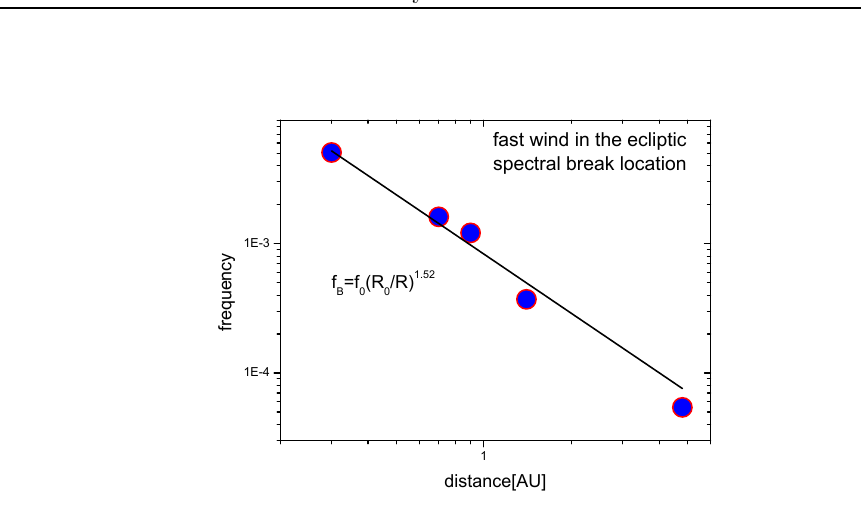
Figure 30: Radial dependence of the frequency break observed in the ecliptic within fast wind as shown in the previous Figure 29. The radial dependence seems to be governed by a power-law of the order of 𝑅 − 1 . 5